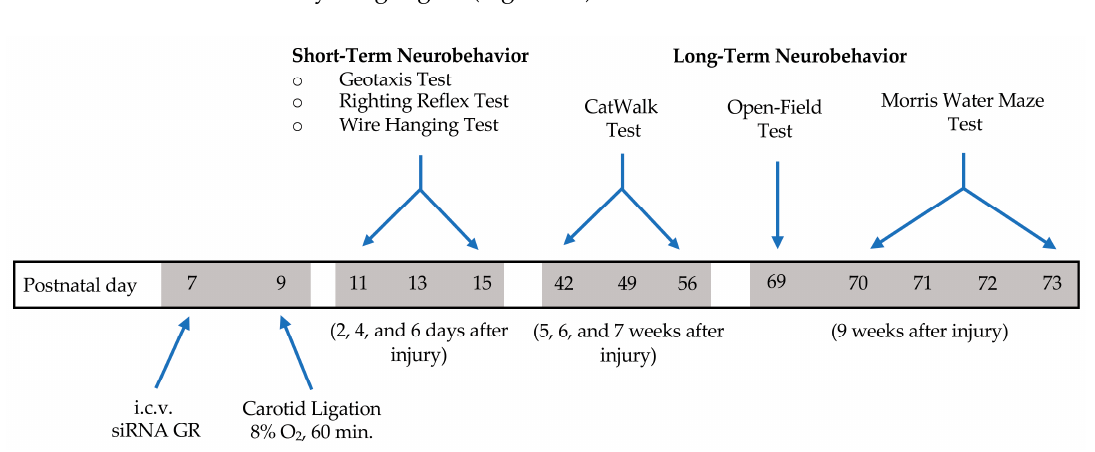
Figure 3. Design / timeline of short- and long-term behavioral tests after hypoxic-ischemic injury. The neonatal male rats received GR siRNA (100 pmol) or negative control (100 pmol) by ICV injection on postnatal day 7 (P7). Animals were then divided into two groups, Sham and HIE. Hypoxic-ischemic injury was performed on postnatal day 9 with carotid ligation and subsequent 8% O 2 exposure for 60 min. Animals in sham group had carotid arteries exposed without subsequent hypoxic-ischemic injury induction. HI-injury was performed on postnatal day 9 (P9) for 60 min in 8% FiO 2 . Pups were returned to dams. Neurobehavioral tests began two days after injury and extended to 9 weeks after initial injury.